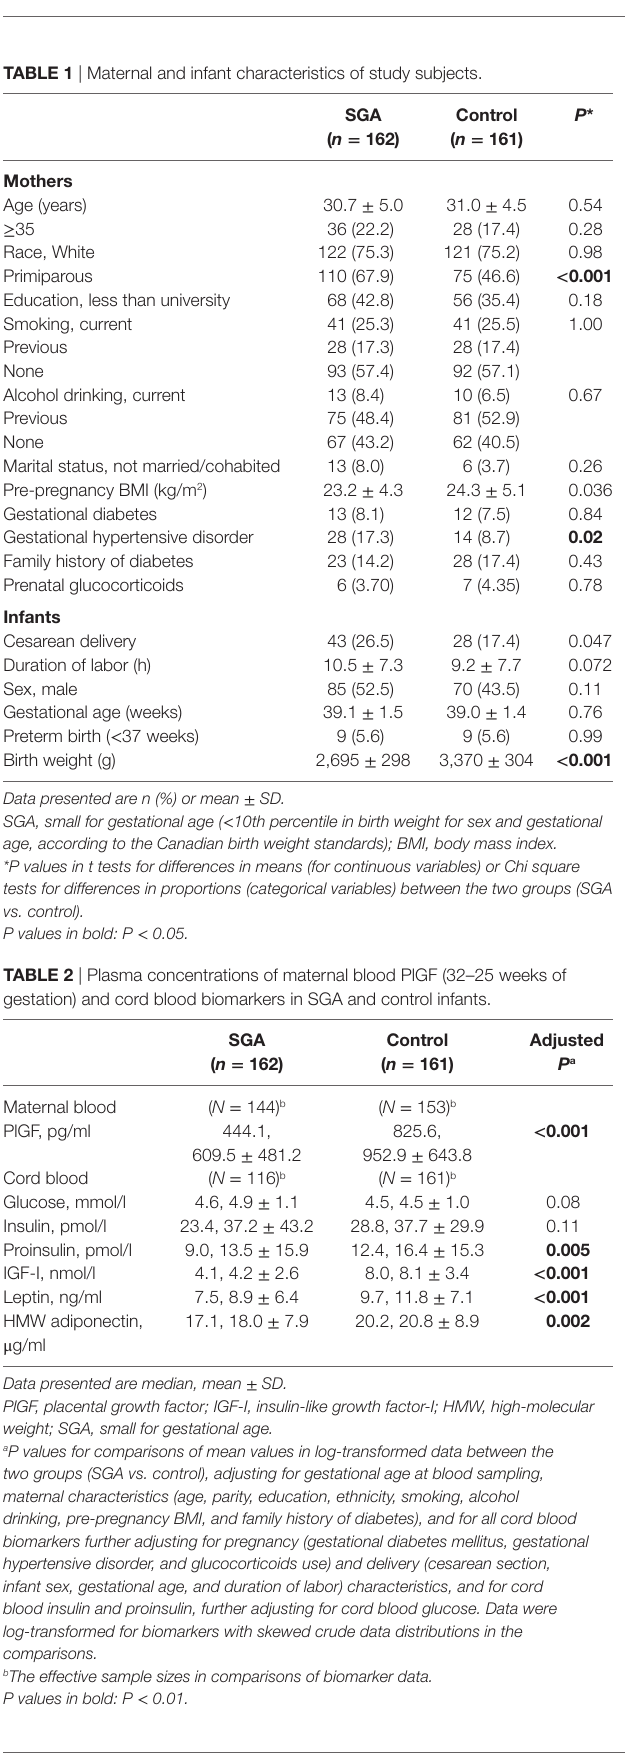
Table 4 presents cord blood metabolic health biomarkers in SGA infants stratified by maternal circulating PlGF concentration at 32–35 weeks of gestation: “low” (below the 25th percentile